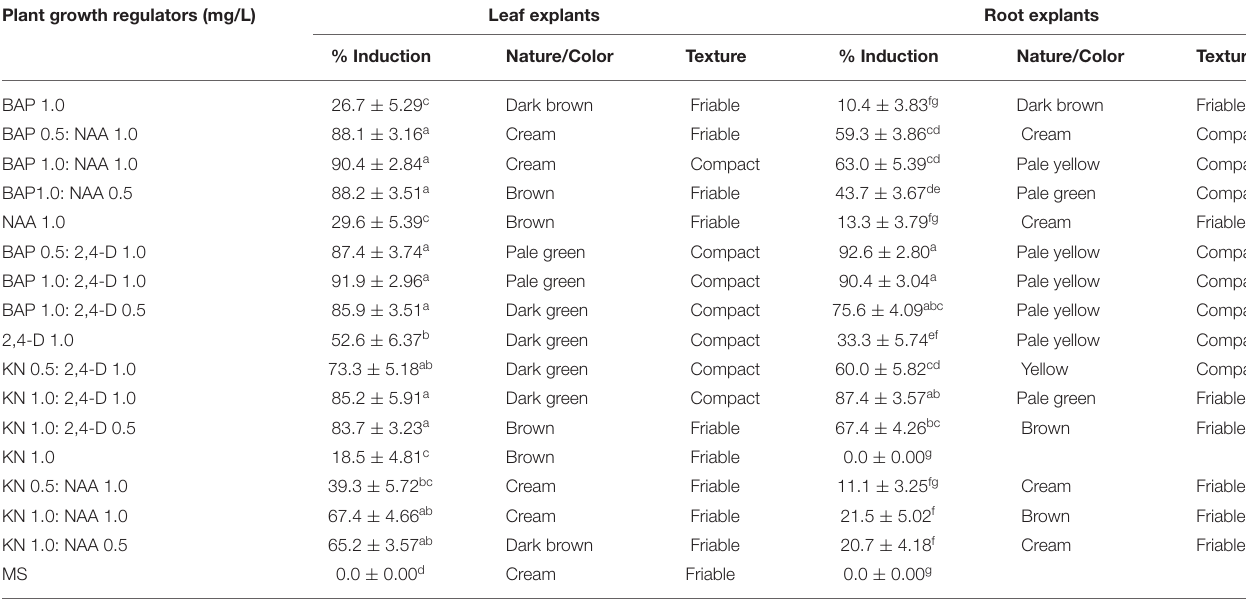
TABLE 1 | Percentage induction and characteristics of callus from leaf and root explants of Aspilia africana . Plant growth regulators